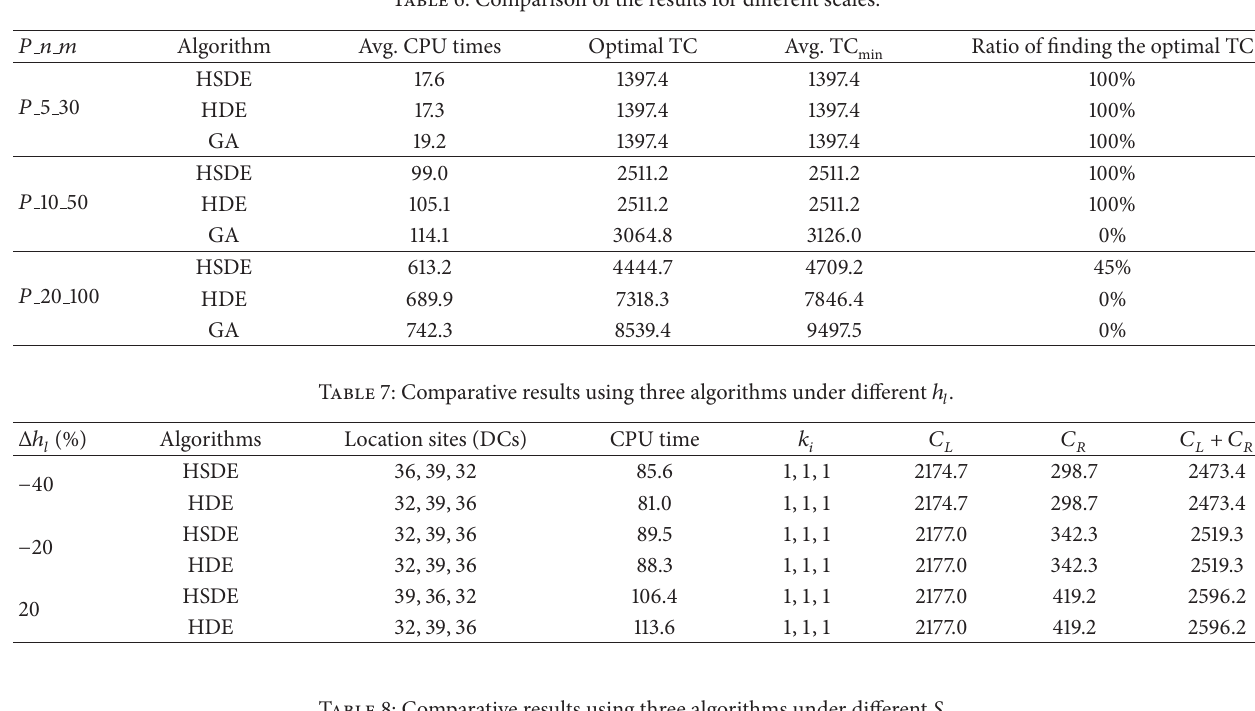
Table 8: Comparative results using three algorithms under different